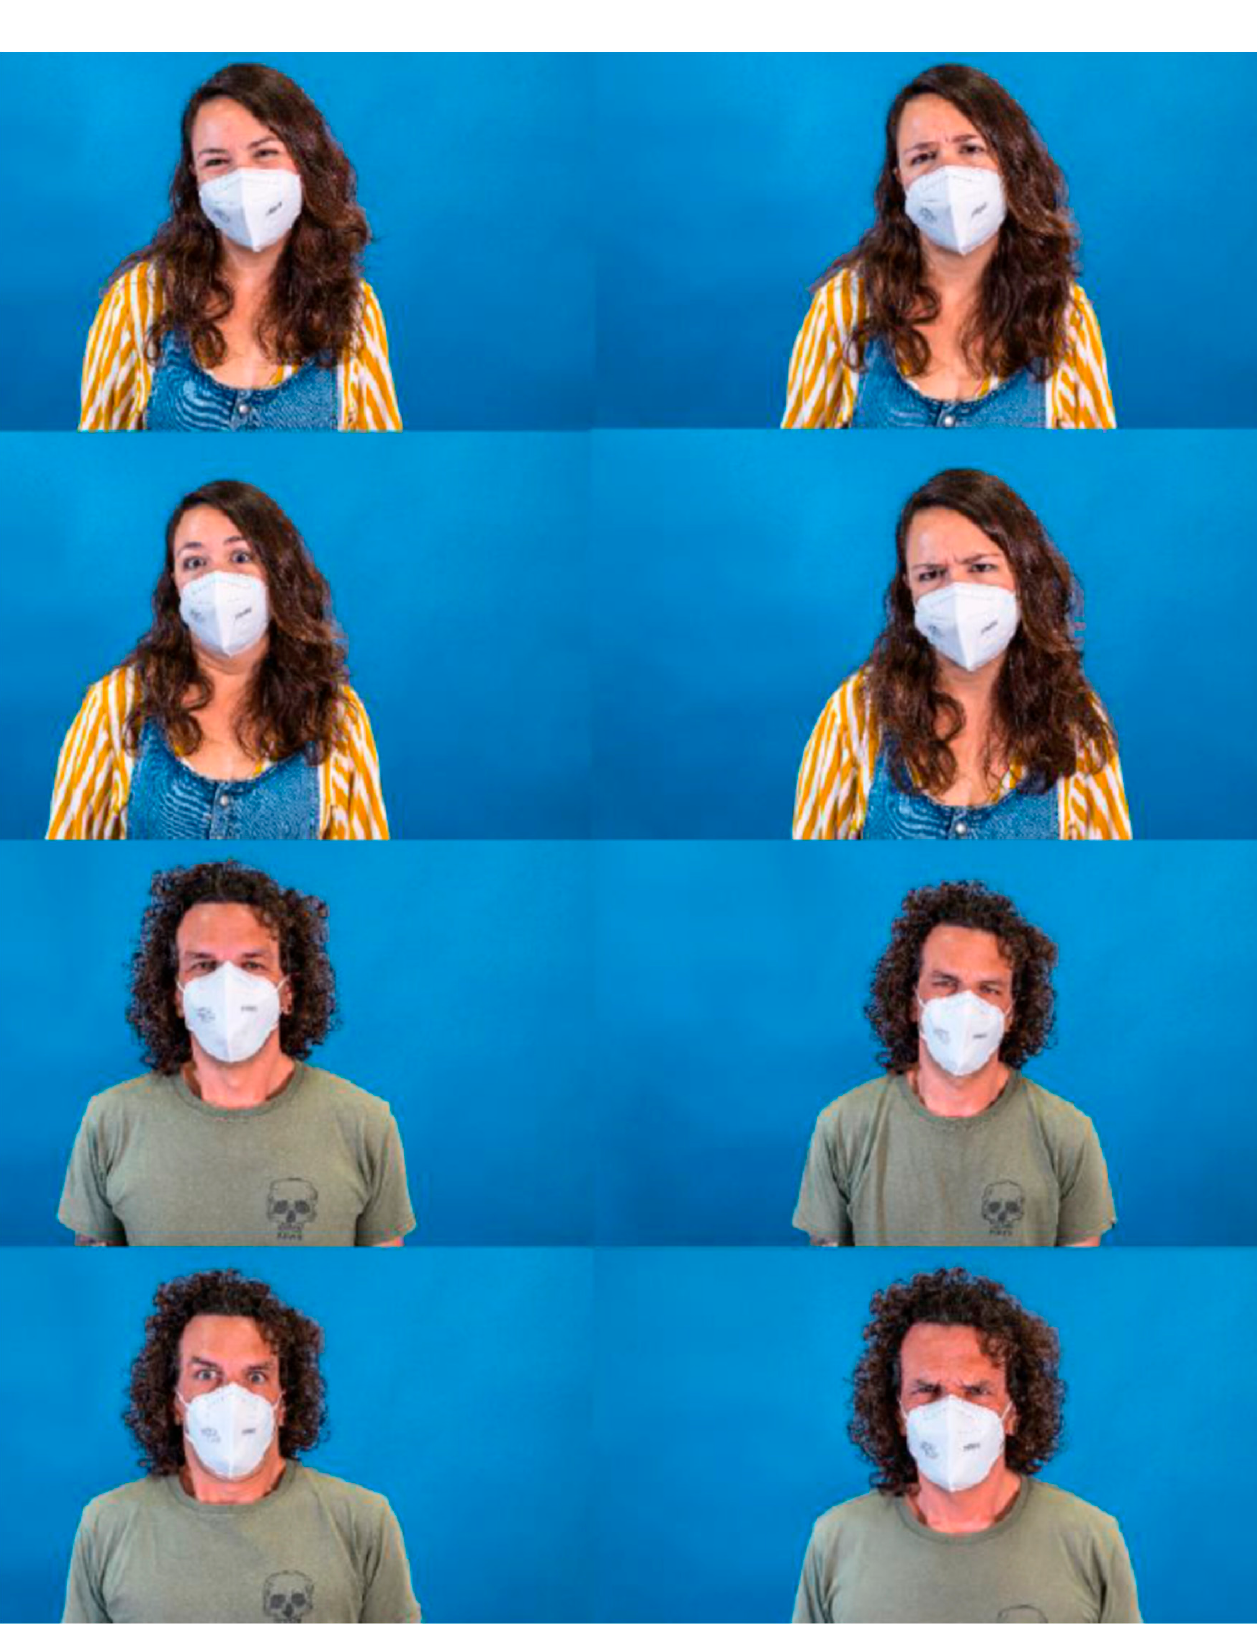
Figure 2. Photographs of the four emotions by an actress and an actor with an FFP2 mask (from left to right: happy; sad; fear/surprise; and disgust/anger).